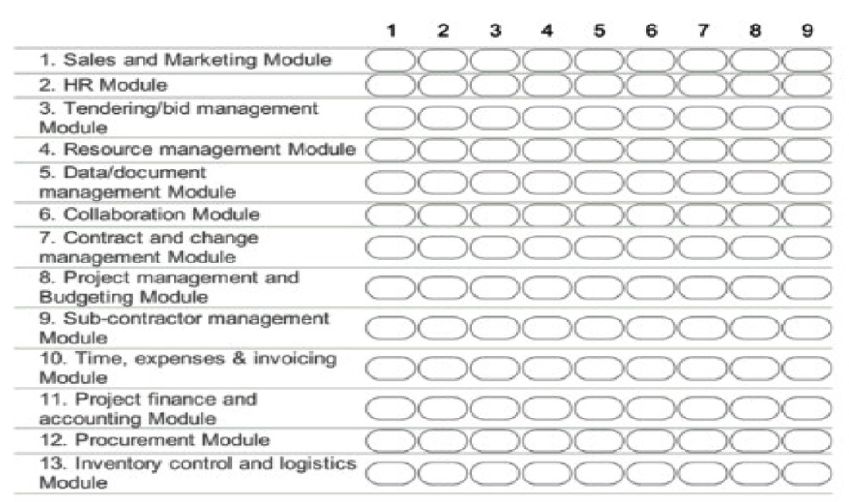
Fig. 3. Modules’ evaluation for each